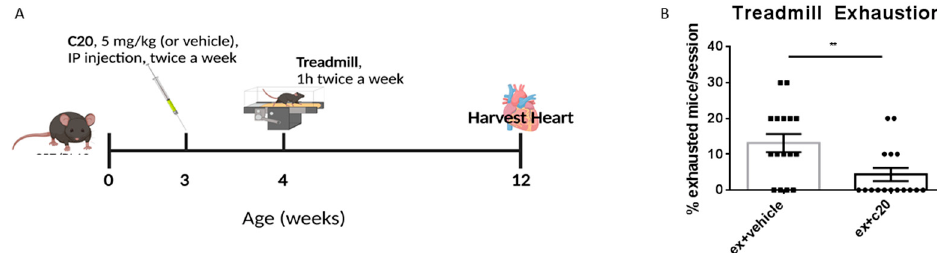
Figure 1. C20 twice-a-week administration increases running performance in the mdx mice. ( A ) A schematic description of the C20 treatment and exercise protocol. ( B ) Percentage of mice exhausted per exercise session, expressed as mean +/ − S.E.M.; ** p < 0.01, unpaired t -test w/Welch’s correction. N = 10 mice/exercise session.